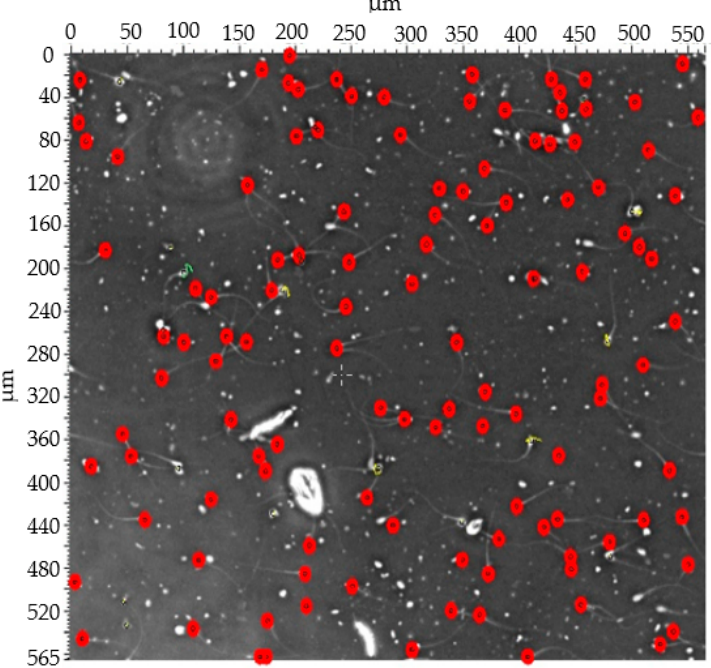
Figure 8. The sample was investigated via computer-assisted sperm analysis (CASA), which is standard for semen analysis.